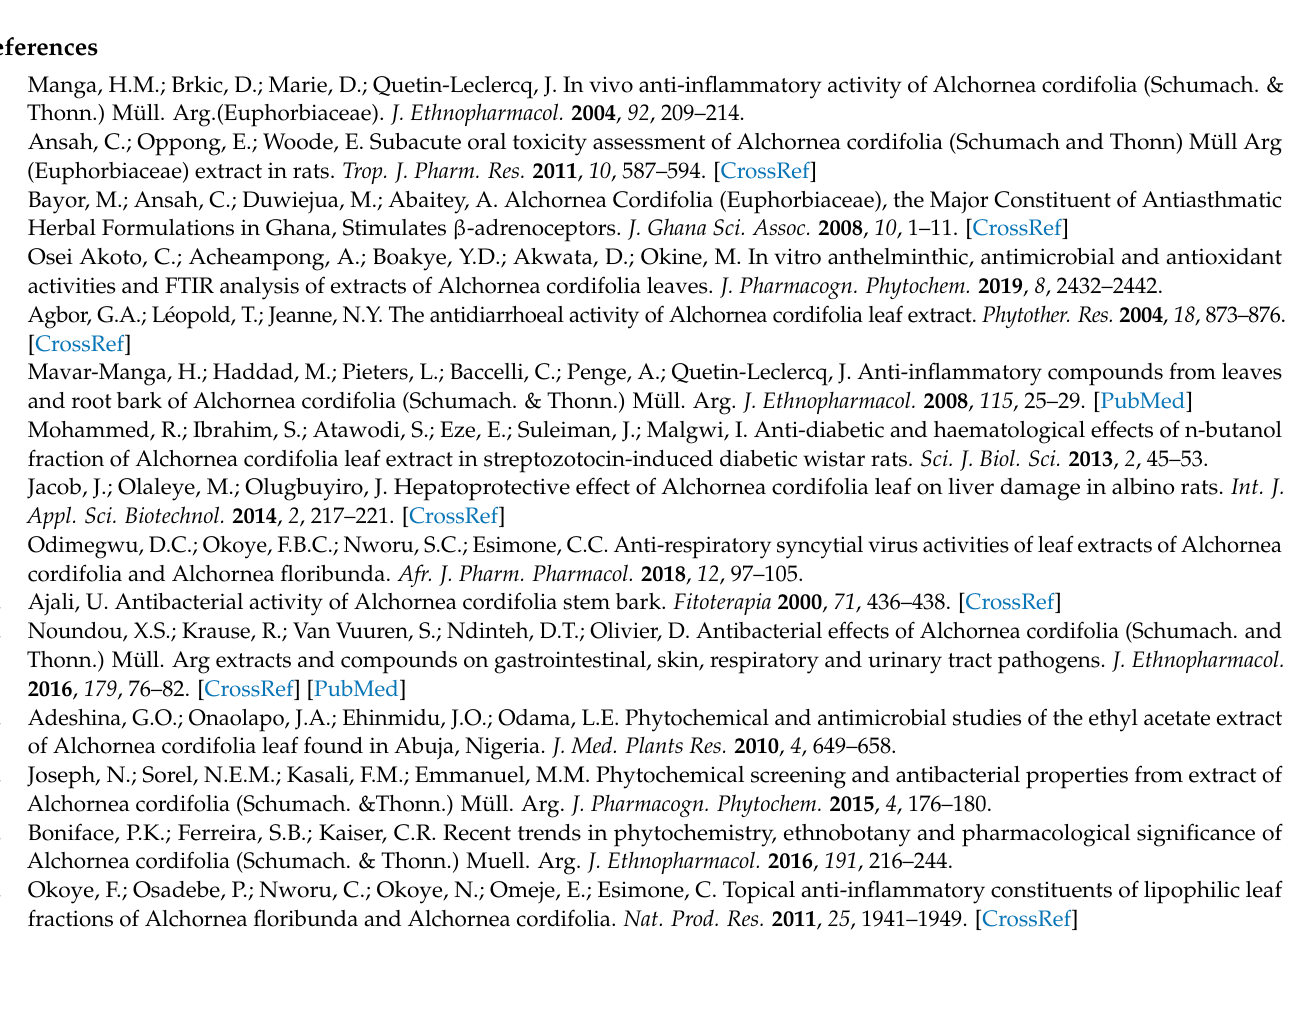
composition of methanol extract. Table S3: Chemical composition of water extract. Figure S1: Total ion chromatogram of ethyl acetate extract in positive ion mode. Figure S2: Total ion chromatogram of ethyl acetate extract in negative ion mode. Figure S3: Total ion chromatogram of methanol extract in positive ion mode. Figure S4: Total ion chromatogram of methanol extract in negative ion mode. Figure S5: Total ion chromatogram of water extract in positive ion mode. Figure S6. Total ion chromatogram of water extract in negative ion